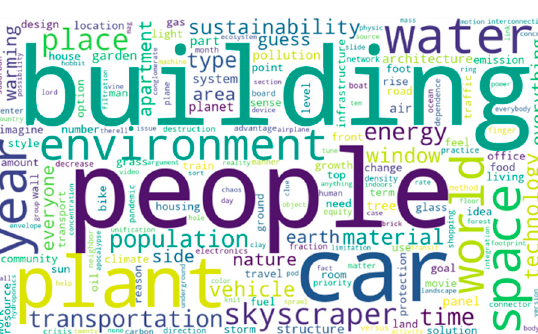
Figure 7. Frequency of concepts for the brainstorming tasks in a room with an algae facade and without an algae façade.